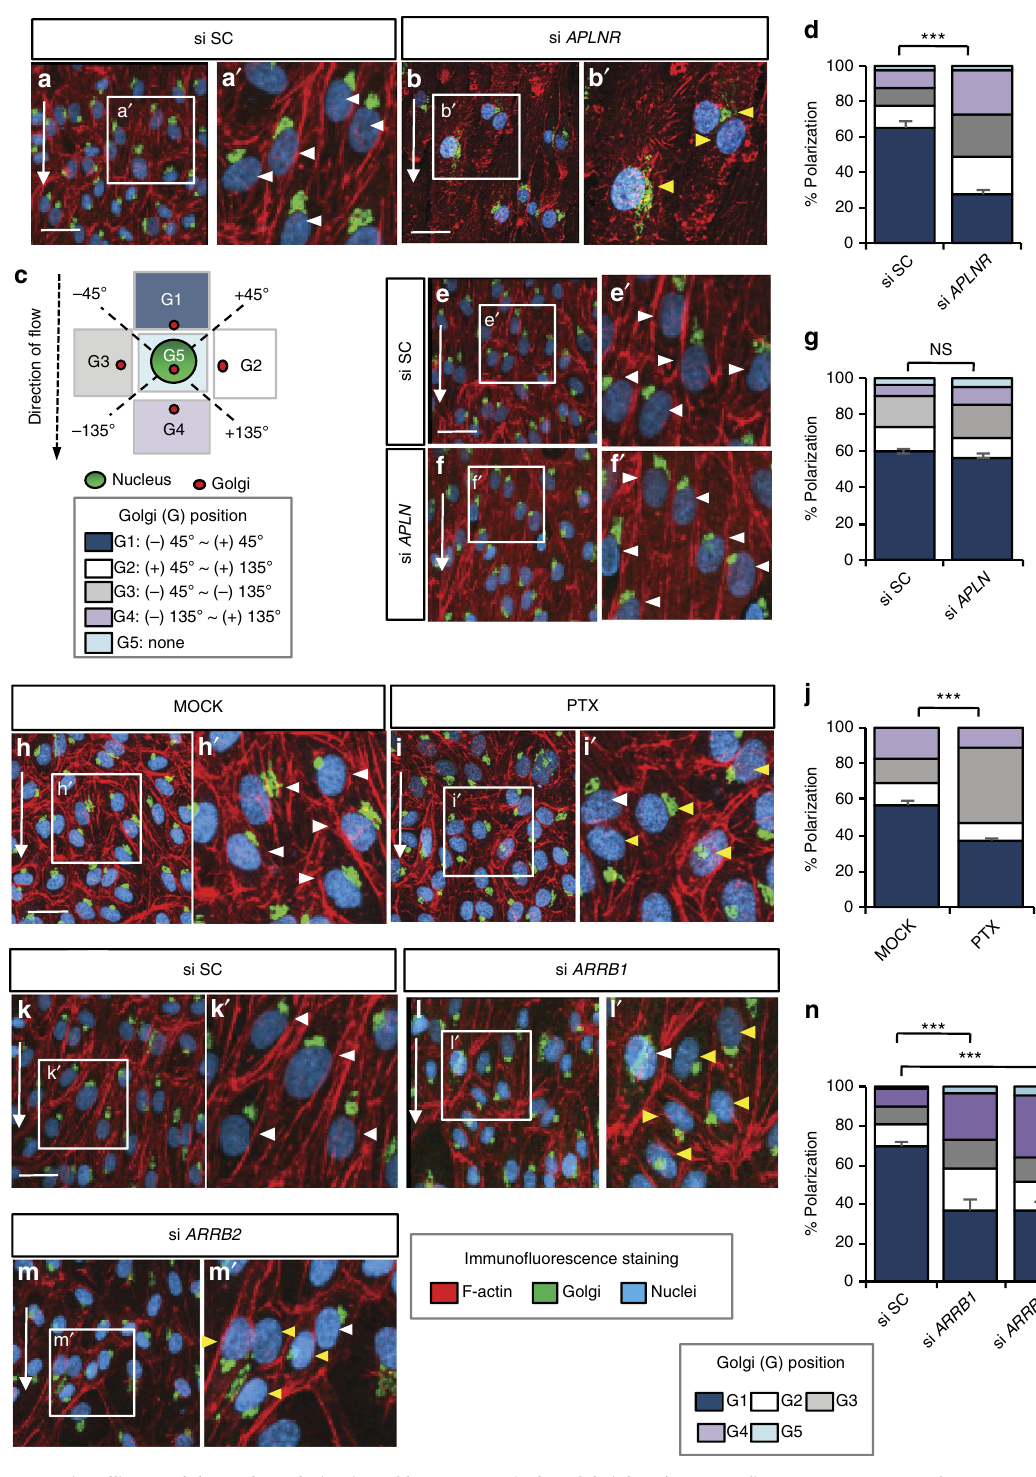
Figure 5 | APLNR signalling modulates the polarization of human ECs. ( a – b’ , e – f’ , h – i’ , k – m’ ) Immunofluorescence staining of HUVECs transfected with si SC or si APLNR ( a – b’ ), transfected with si SC or si APLN ( e – f’ ) treated with water (MOCK) or the G a i inhibitor PTX (100ng ml (cid:2) 1 ) ( h – i’ ) and transfected with si SC, si ARRB1 or si ARRB2 ( k – m’ ) subjected to laminar flow at 12dynescm (cid:2) 2 for 18h. Cells were fixed and stained with the GM130 Golgi antibody (green), Phalloidin (red) and 4,6-diamidino-2-phenylindole (DAPI, blue). White arrowheads point to polarized ECs (that is, Golgi apparatus positioned within ± 45 (cid:2) against the direction of laminar flow (G1)). Yellow arrowheads point to depolarized ECs (tht is, Golgi positioned within þ 45 (cid:2) to þ 180 (cid:2) and þ 180 (cid:2) to (cid:2) 45 (cid:2) against the direction of laminar flow (G2–G4)). ( c ) Schematic representation showing the classification of polarization: The orientation of the Golgi apparatus relative to the nucleus was assessed to define cell polarization under laminar flow. ( d , g , j , n ) Quantitative analysis of polarization of HUVECs subjected to laminar flow at 12dynescm (cid:2) 2 for 18h treated with si SC or si APLNR ( d ) transfected with si SC or si APLN ( g ) treated with water (MOCK) or the G a i inhibitor PTX (100ngml (cid:2) 1 ) ( j ) transfected with si SC, si ARRB1 or si ARRB2 ( n ). n 4 300 cells, from at least three independent experiments. Scale bars, 20 m m. Error bars,